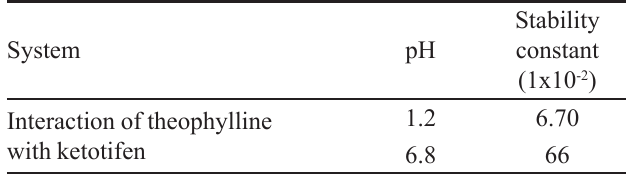
FIGURE 2 - Ardon’s plot for the complexation of ketotifen with theophylline at 300 TABLE III - Stability constant of ketotifen with theophylline at different pH